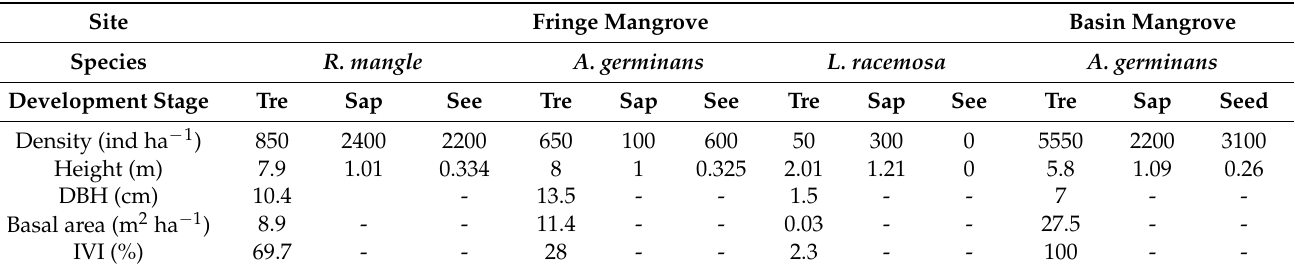
Table 1. Forest structure of the study sites. There were no data on the impaired site because of the absence of live vegetation. Tre = Trees, Sap = Saplings, See = Seedling. Fringe Mangrove Basin